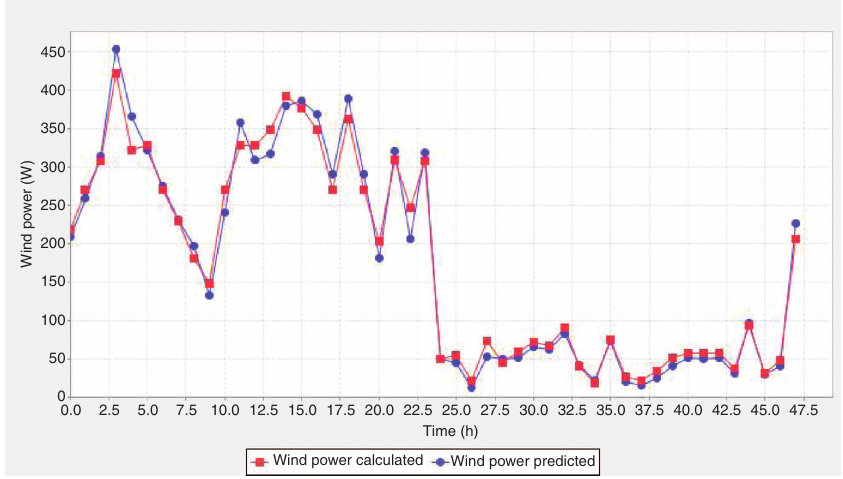
Figure 14: Wind Power Predicted by ELM and Calculated by Mathematical